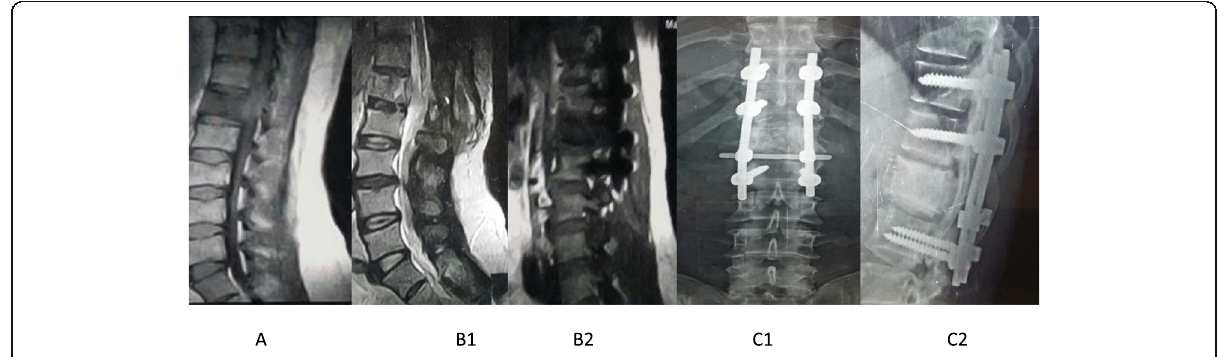
Fig. 3 Case of spinal cancer bladder metastases. A Preoperative T1 MRI with contrast of lumber spine cancer bladder metastases. B1 Central sagittal postoperative MRI. B2 Peripheral sagittal postoperative MRI. C1 , C2 Postoperative plain X-ray showing instrumental reconstruction